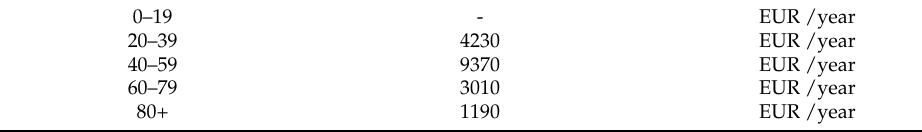
Table A1. Average annual tax income per capita per age cohort (2020, NL).